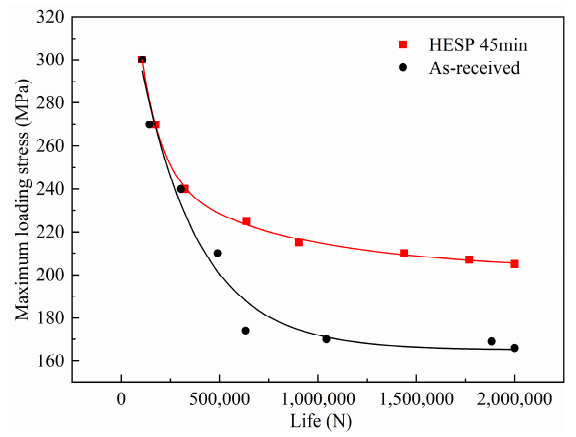
Figure 7. Residual stress profile of the HESPed in different depth.